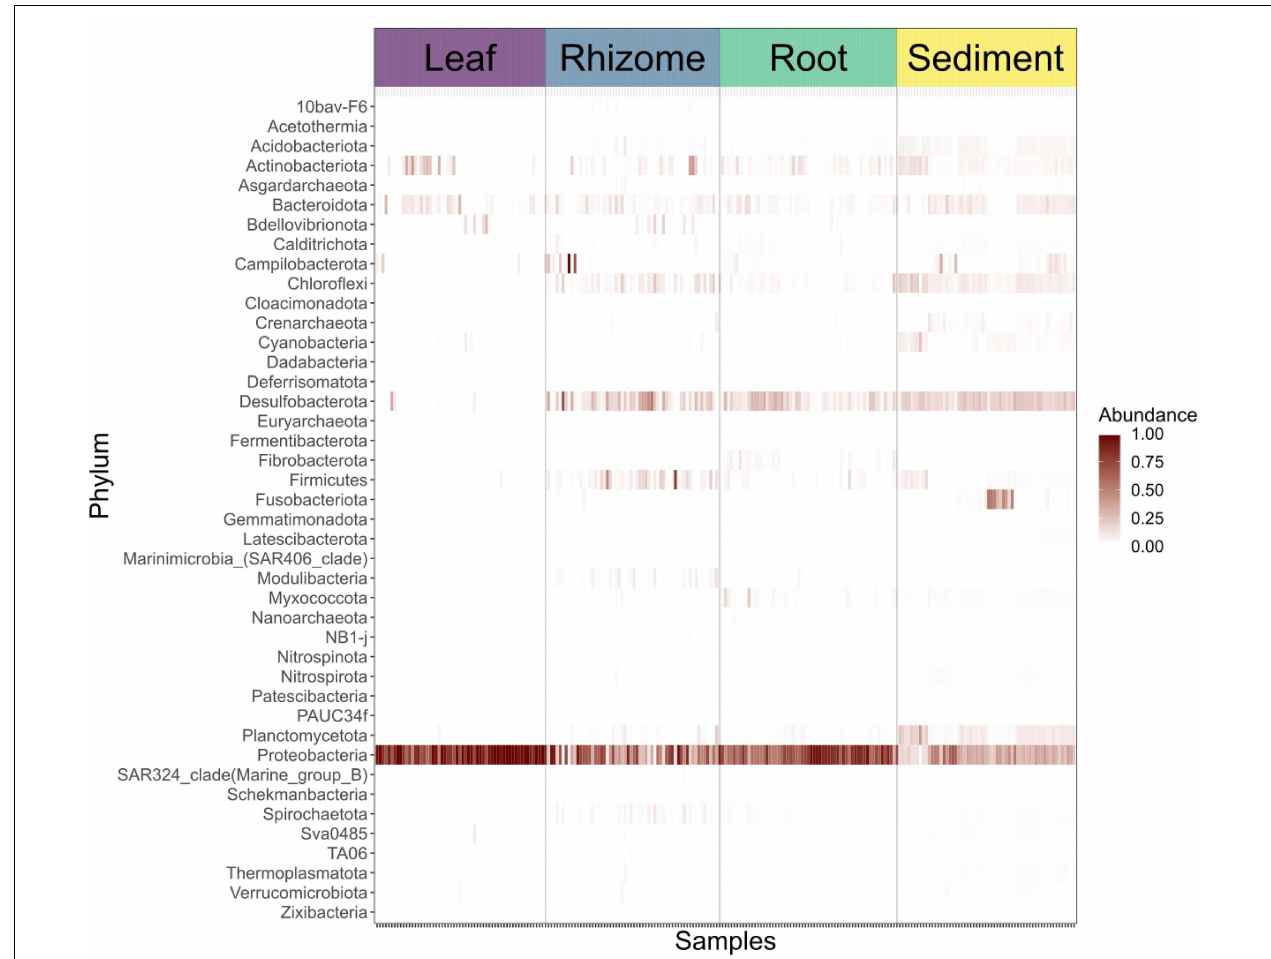
FIGURE 5 | Heat map showing the abundances of bacterial phyla in sediment samples and specific plant parts.